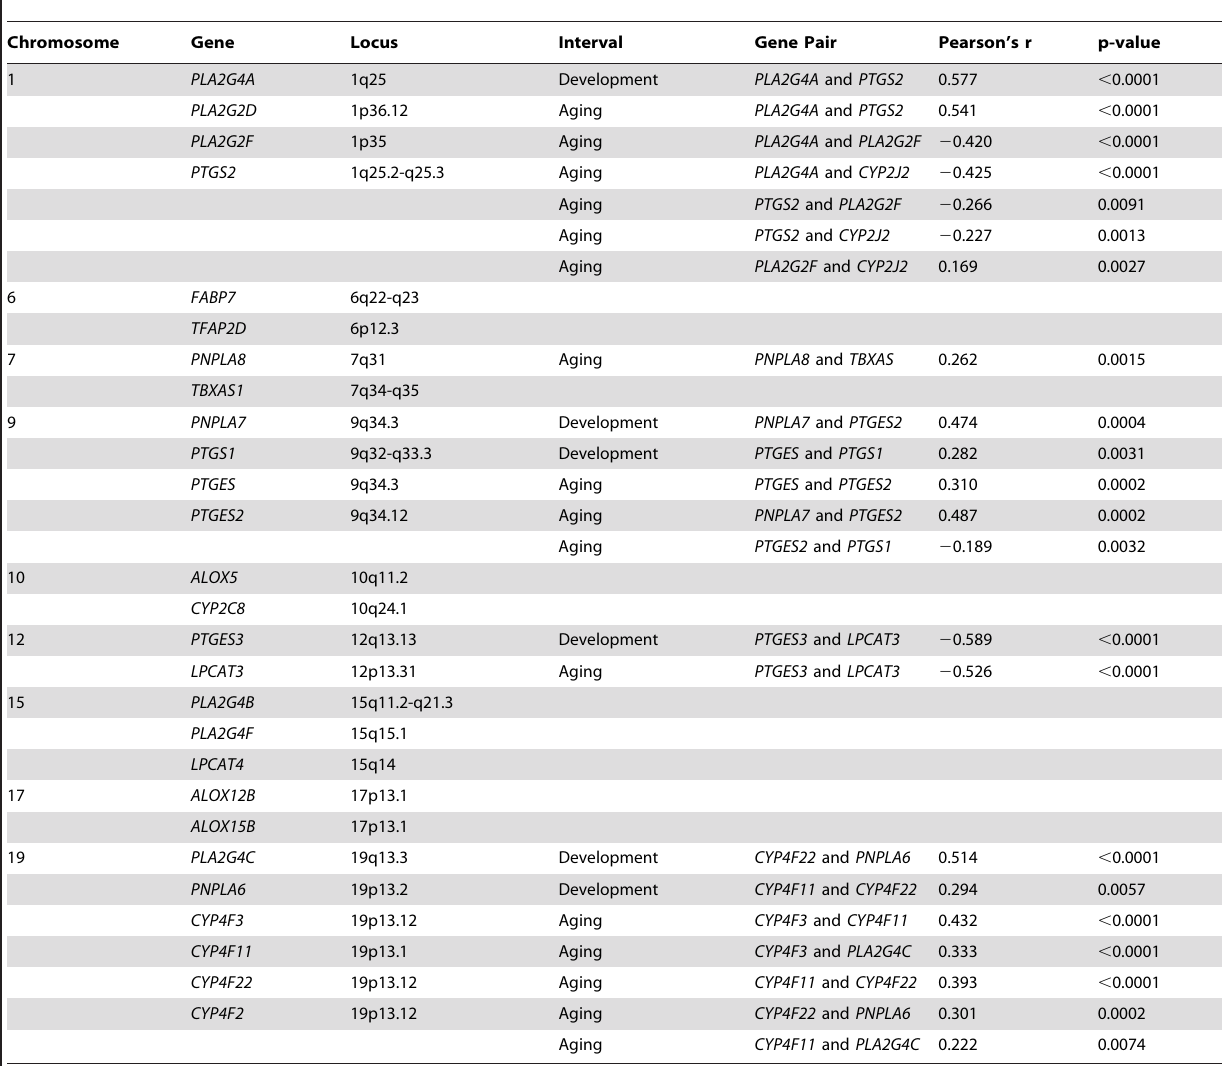
Table 2. Correlations between pairs of genes on the same